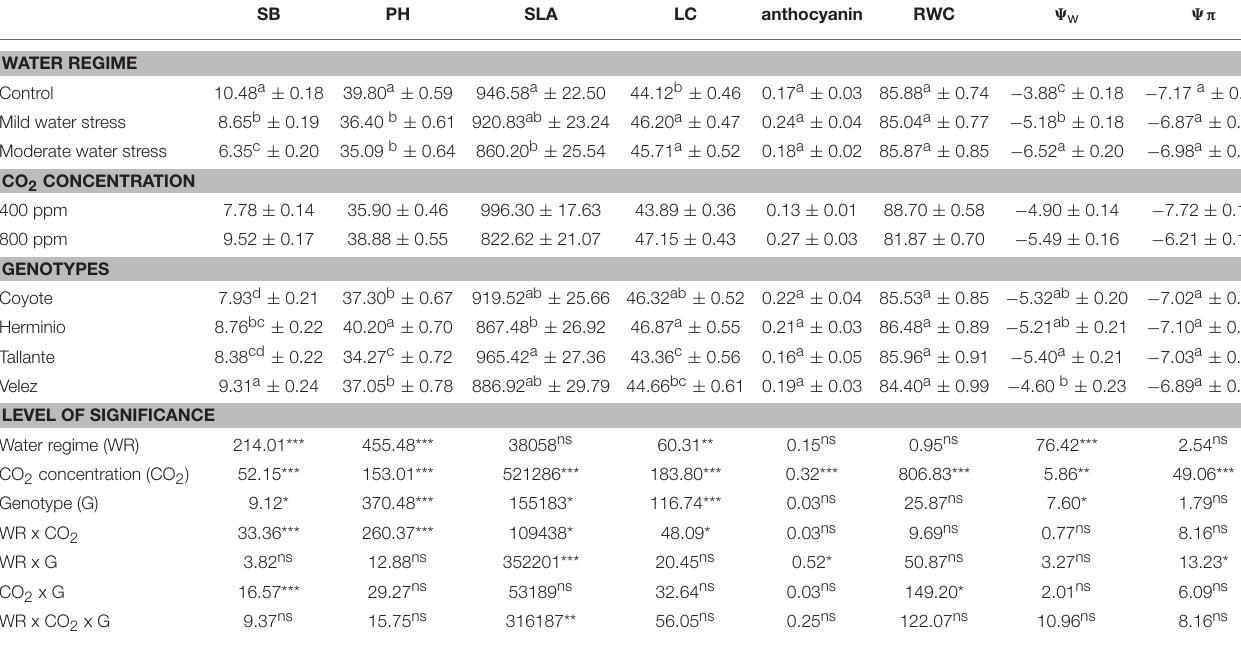
TABLE 1 | Water regime, CO 2 concentration and genotype effects on biomass, growth parameters, anthocyanin content, and leaf water status of four sweet pepper genotypes grown under different combinations of CO 2 concentration and water